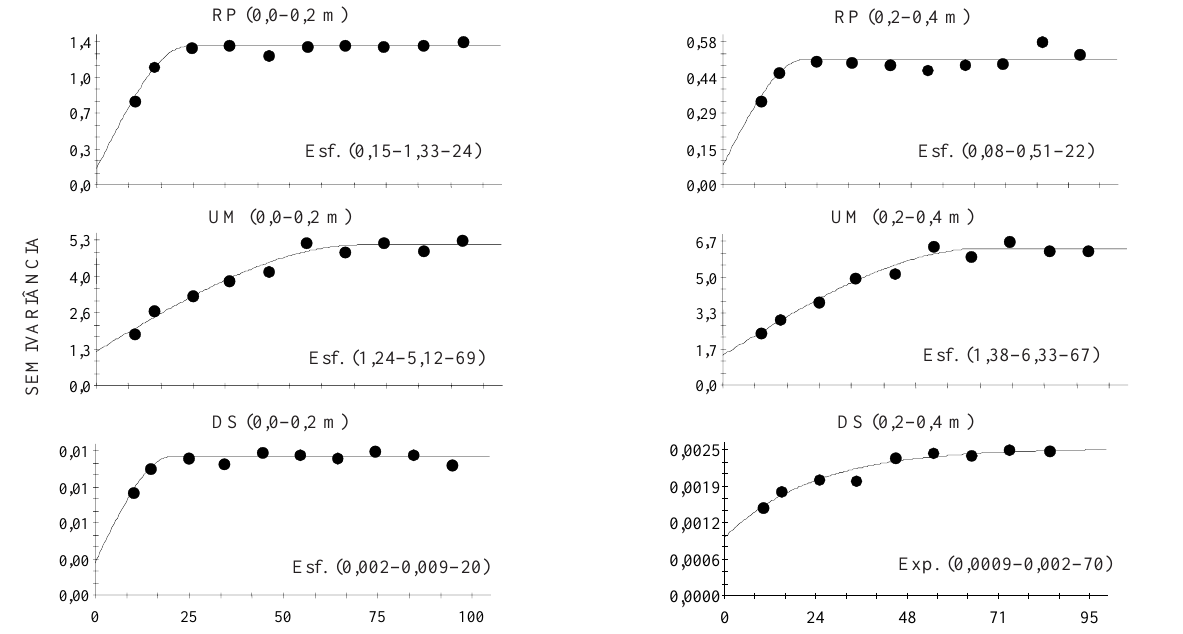
(1) RP = resistência à penetração. (2) UM = umidade do solo. (3) DS = densidade do solo. (4) C = alcance. (7) C